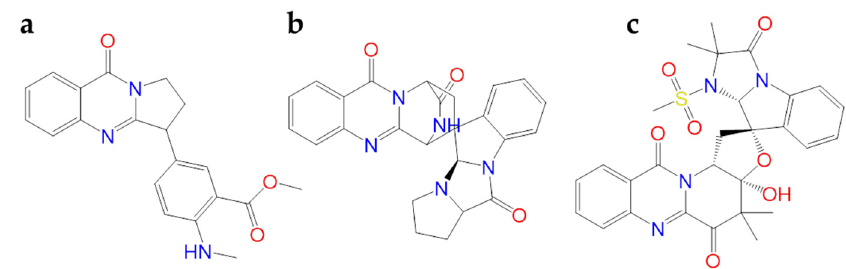
Figure 14. 2D structures of ( a ) anisotine, ( b ) quinadoline B and ( c ) scedapin C.